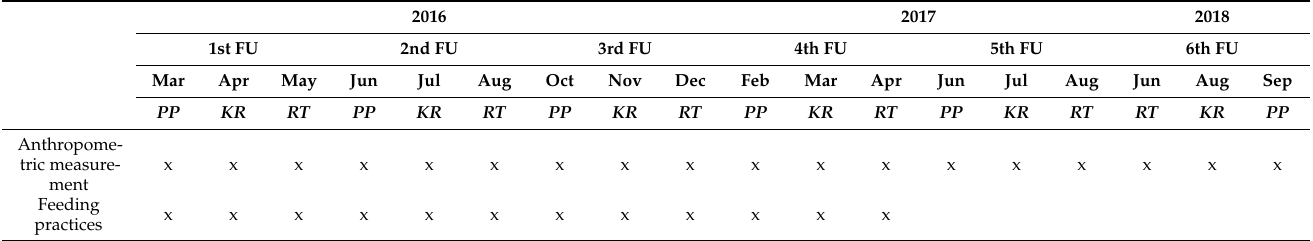
Table 1. Timeline of follow-ups (FUs) for the study.